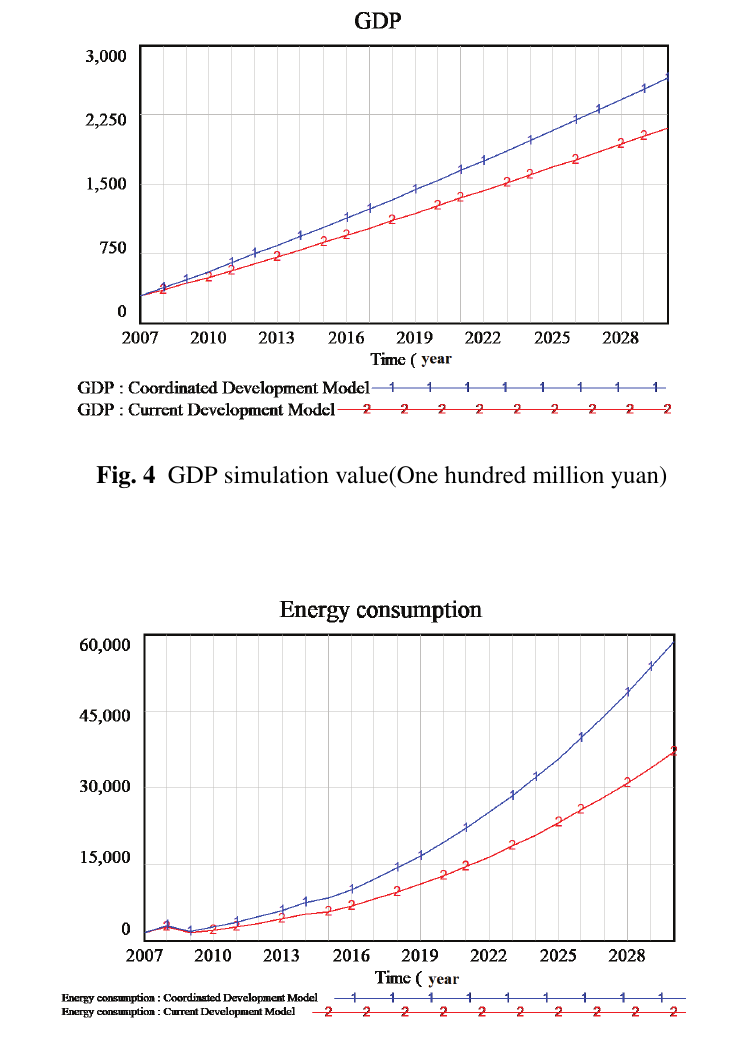
Fig. 5 Energy consumption simulation value(10,000 tons of standard